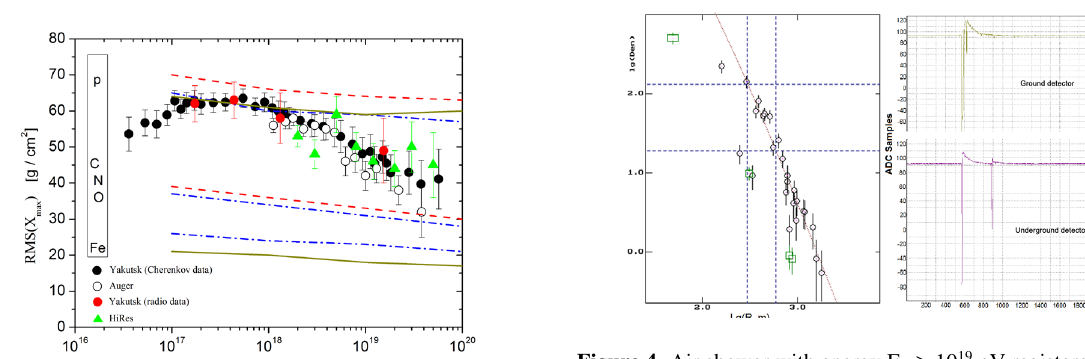
Figure 4. Air shower with energy E 0 Yakutsk array on January 2018